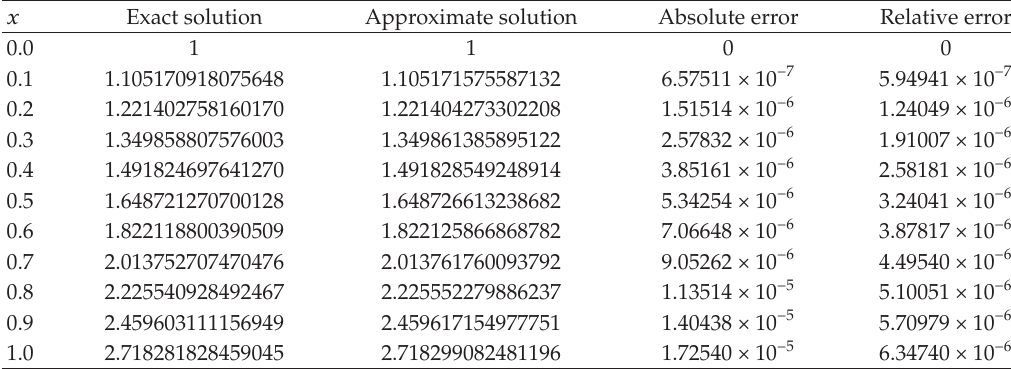
Table 4: Numerical results for Example